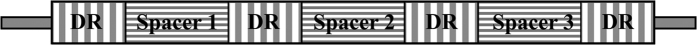
The schematic structure of a CRISPR.A number of spacer sequences (Spacers 1–3 in horizontal-line shaded boxes) are flanked by the highly conserved direct repeats (DRs in vertical-line shaded boxes).The DRs and spacers together constitute a CRISPR.